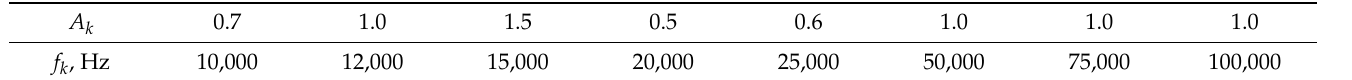
Table 1. Values of natural frequencies and their corresponding amplitudes, which are the parameters of the